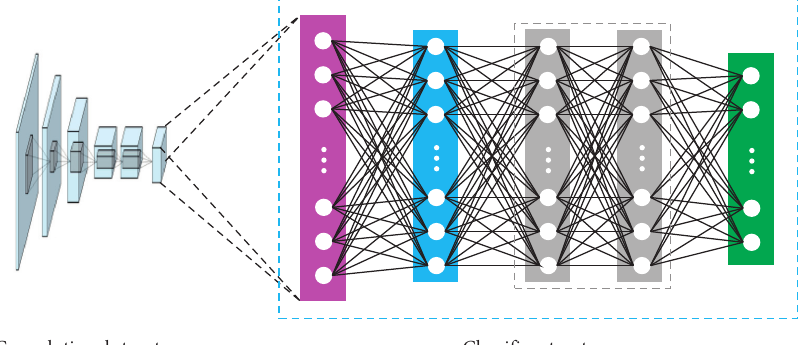
Figure 4: The diagram of the classifier structure.